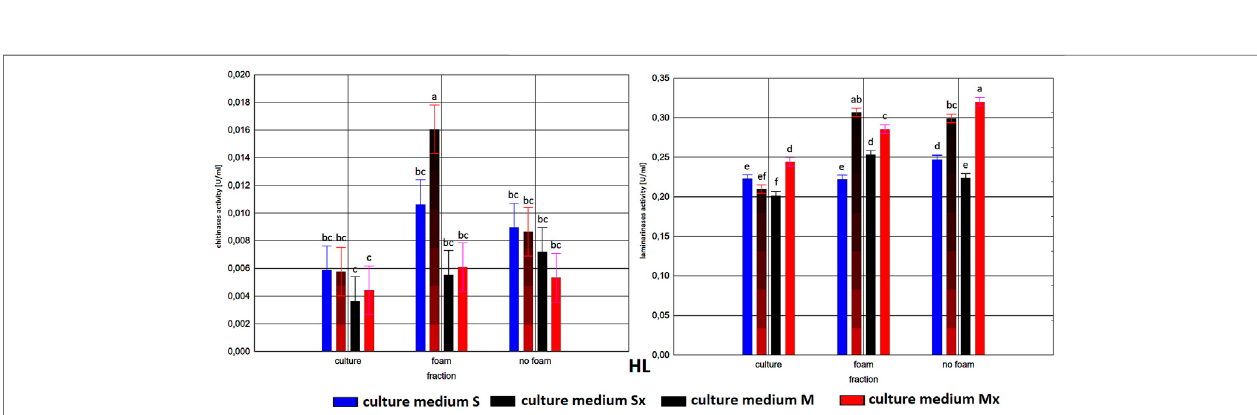
FIGURE3| Enzymatic activities inthree fractions:raw (R),foam (F), foaming residue (FR), of Trichodermacitrinoviride HLstraincultivated indifferentculture media, after separation with foaming technique (M) MGP medium, (S) Saunders medium, (Mx) MGP medium with inductors, (Sx) Saunders medium with inductors. One-way analysis of variance (ANOVA) was applied; a ... i — homogeneous groups according to Duncan ’ s test.